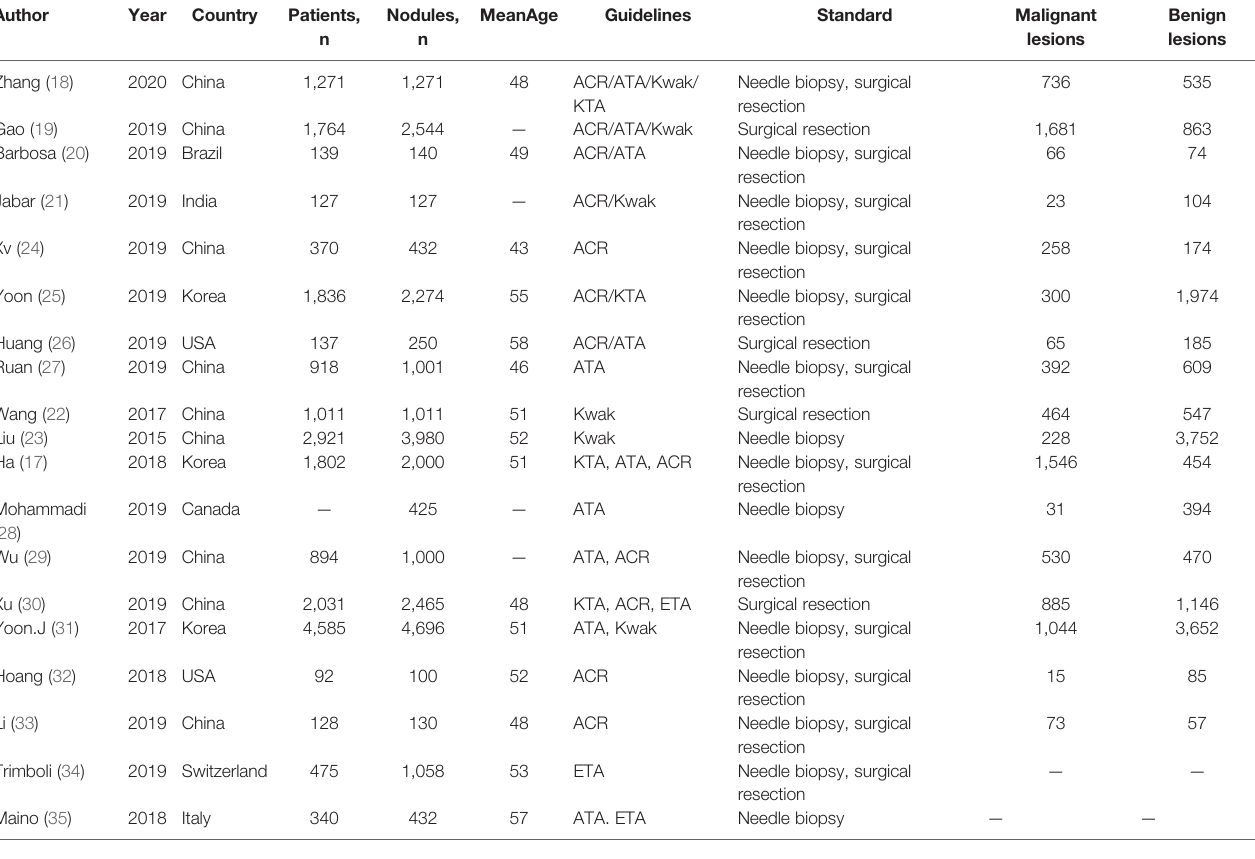
TABLE 1 | Baseline characteristics of included studies.